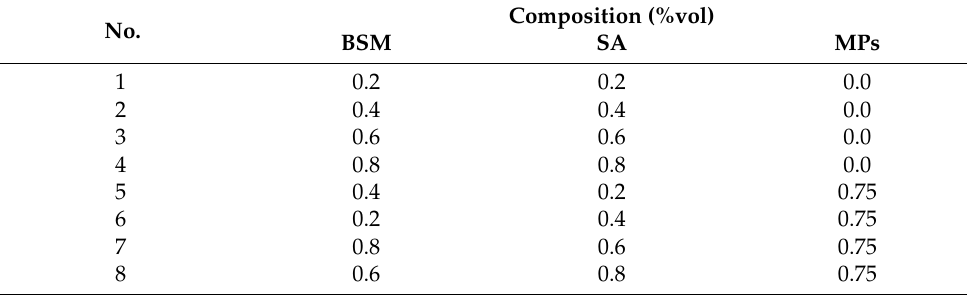
Table 5. Taguchi experimental